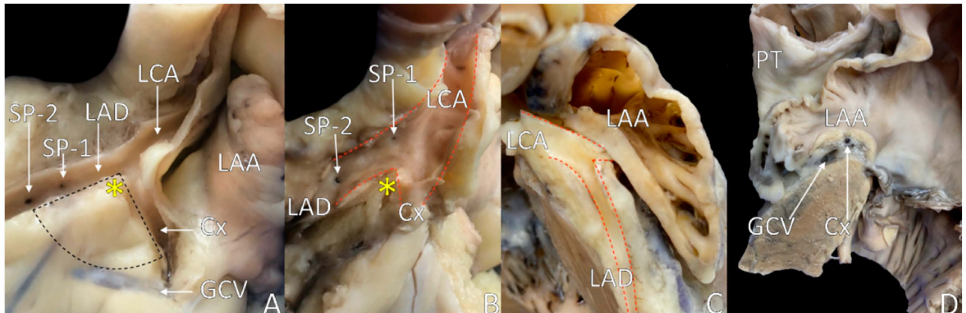
Figure 3. Photographs of cadaveric heart specimens showing the left ventricular summit (LVS) area with opened left coronary artery tree and overlying left atrial appendage (LAA). ( A ) Septal perforators (SPs) are visible in left anterior descending (LAD) artery with SP-1 being small and SP-2 being bigger and dominant. The great cardiac vein (GCV) is running below the SP; thus, the LVS has only an inaccessible area. ( B ) SPs located in the great proximity of the left coronary artery (LCA) ostium: the small SP-1 located in the left coronary artery (LCA) trunk and the dominant SP-2 located near the LCA bifurcation, thus defining a very small LVS area. ( C , D ) The LAA is located directly over the LVS area. Cx = circumflex branch of left coronary artery, PT = pulmonary trunk.